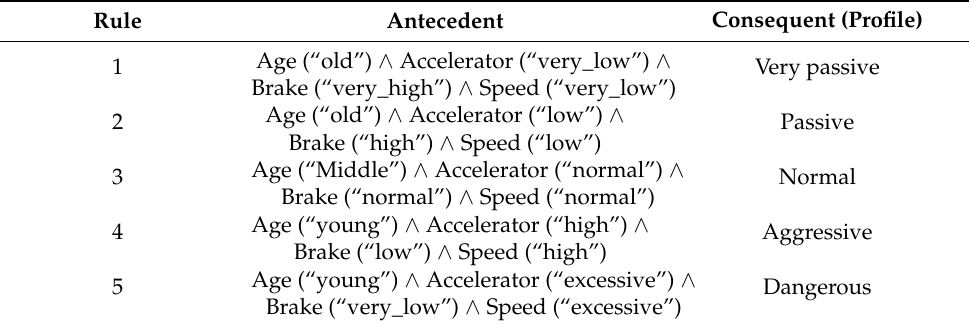
Table 2. Sample rules for the driver classification